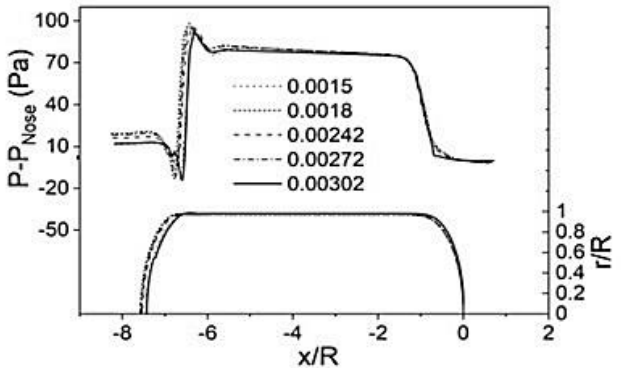
Figure 6. Variation of wall pressure and droplet shape along the axial length of the channel for different Capillary number at β=0.735 when the pressure at the nose of the droplets are transformed to zero and the nose of the droplets are made coincident